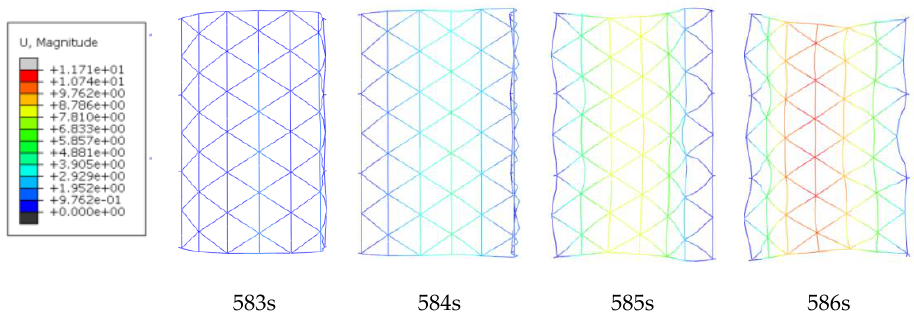
Figure 18. Structural deformation under fire location II.